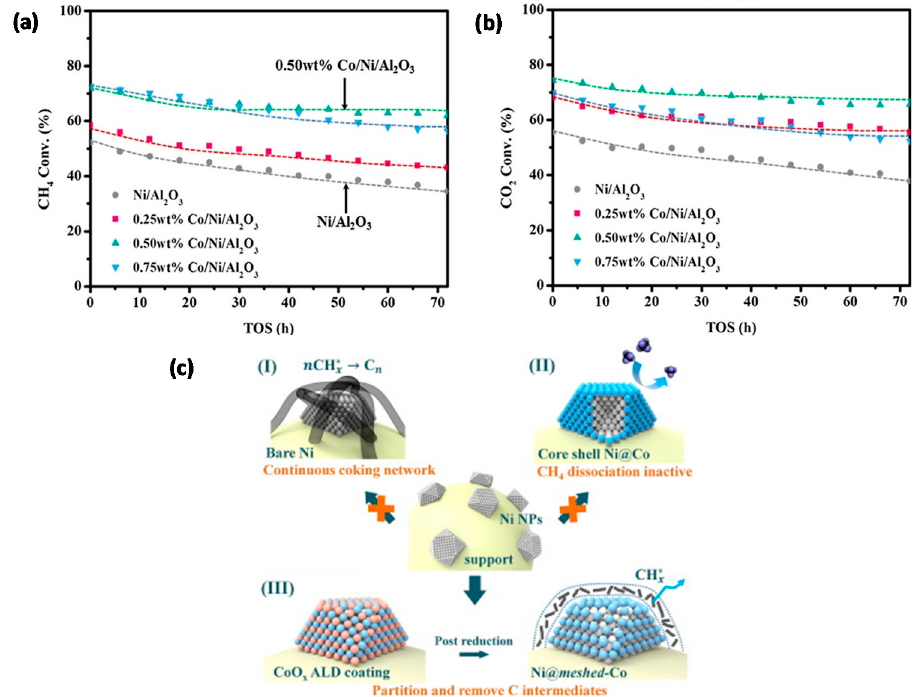
Figure 20. ( a )–( b ) DRM stability test results of Ni/ γ -Al 2 O 3 and meshed Co-coated Ni/ γ -Al 2 O 3 with 0.25, 0.50 and 0.75 wt% Co. Reaction conditions for ( a ) and ( b ): T = 650 °C, P = 1 atm, CH 4 /CO 2 = 1/1 ( V/V ) with flow rate 60 sccm, m cat = 300 mg. ( c ) Structure-property mechanism proposed for Ni-